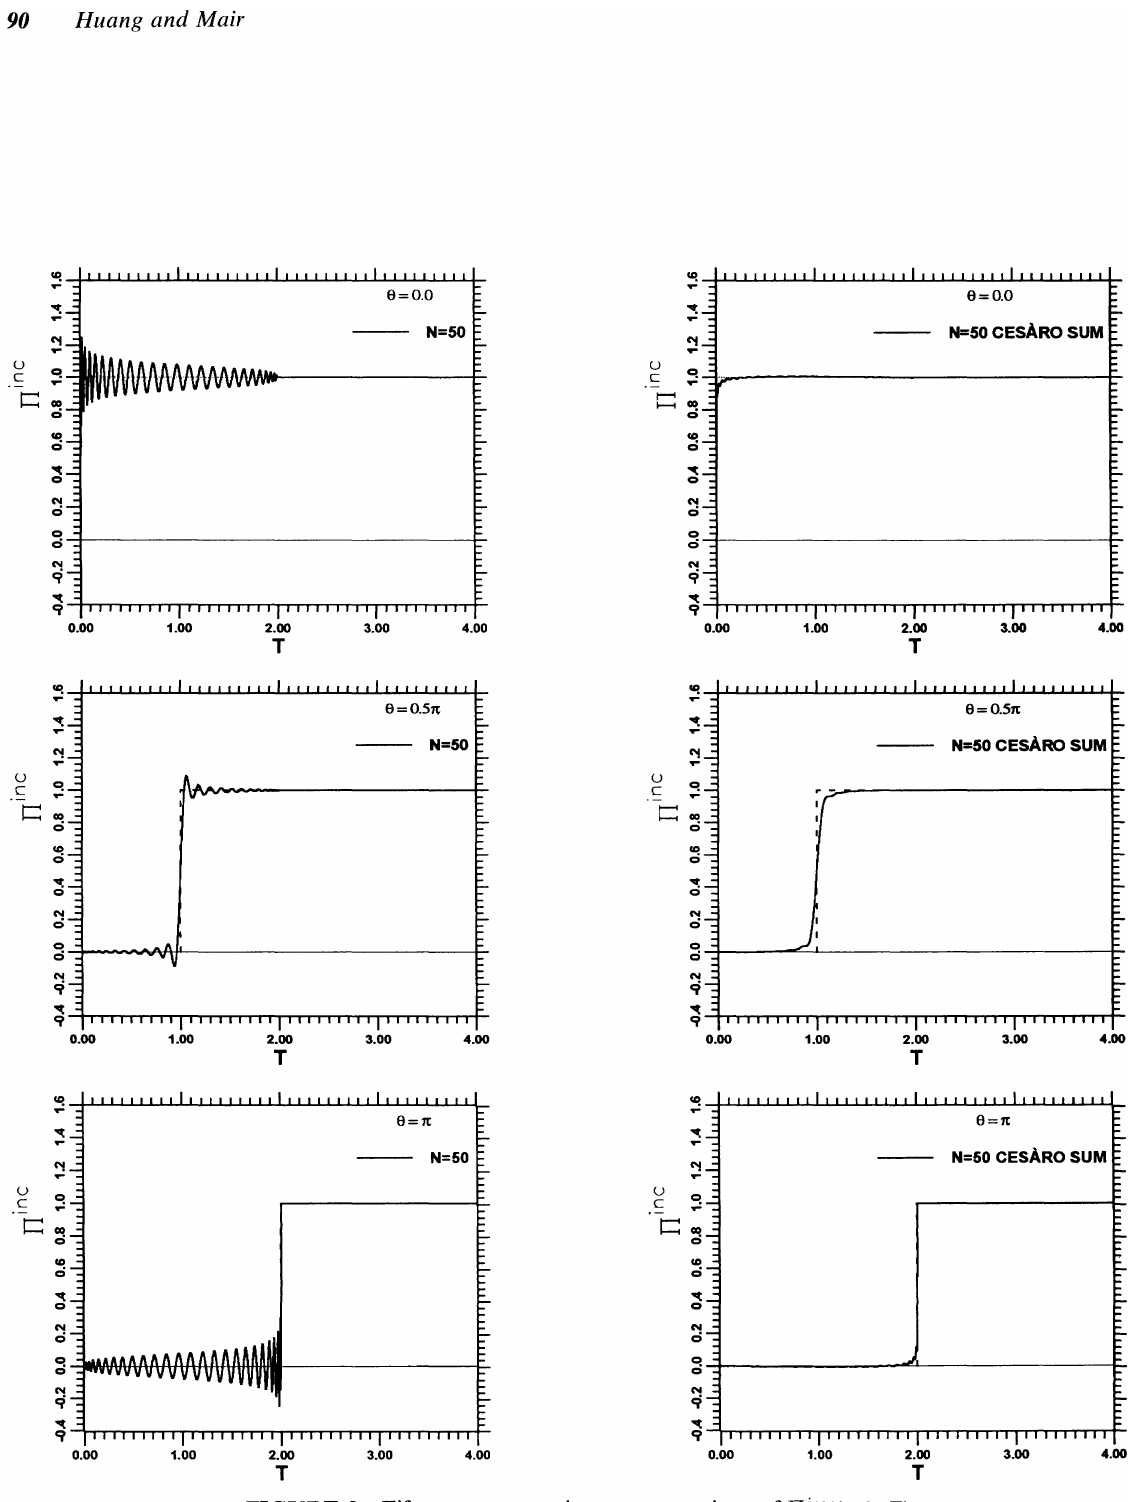
FIGURE 3 Fifty-one-term series representations of IIinc(l, (},